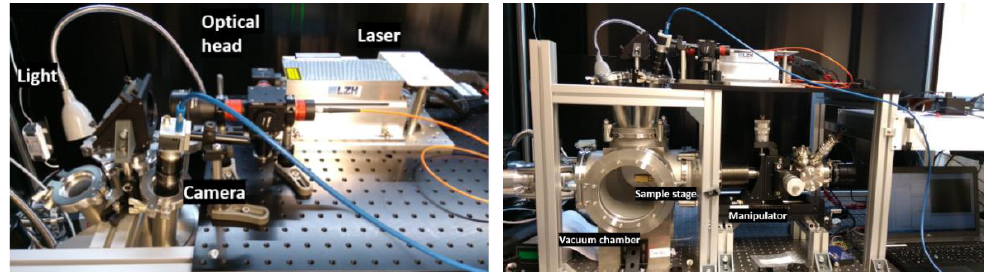
Figure 3. Pictures of the VOILA laboratory demonstration model. ( Left ): laser and optical head can be seen, which guide the laser pulses onto the sample in the vacuum chamber ( right ).